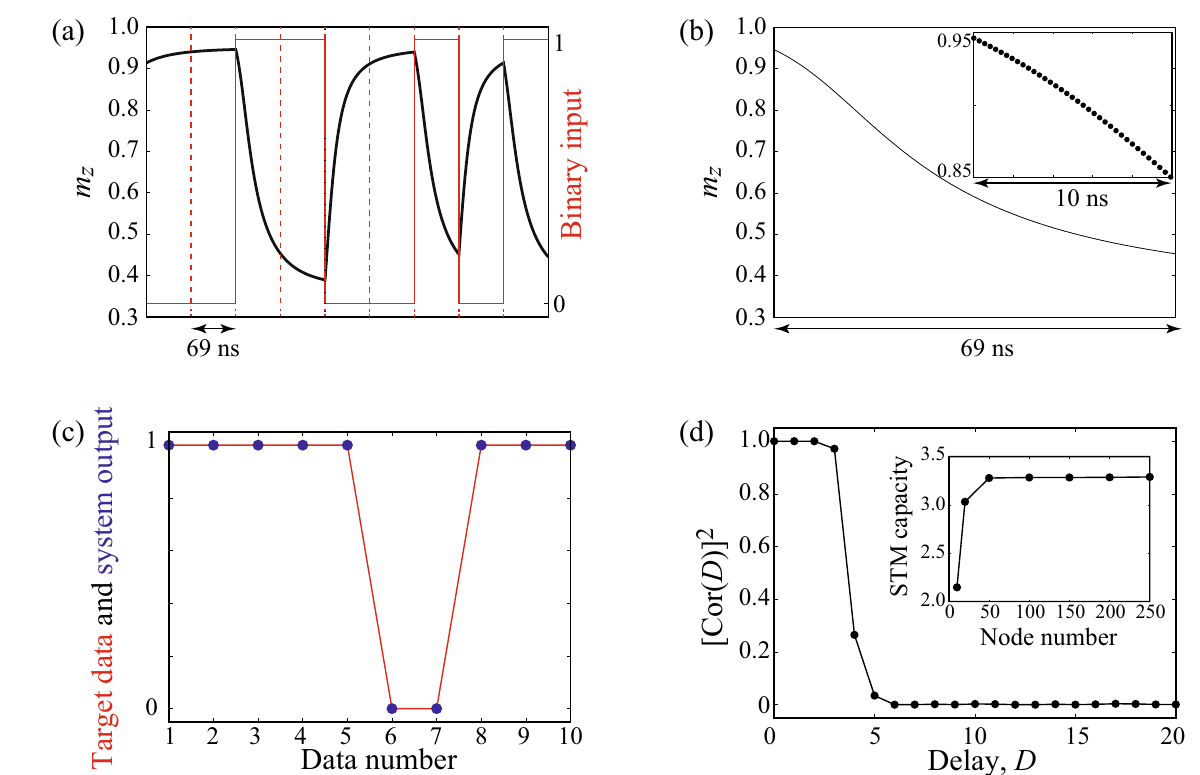
Figure 5. ( a ) An example of the time evolution of m z (black) in the presence of several binary pulses (red). The dotted lines distinguish the input pulse. The pulse width and the first order magnetic anisotropy field are 69 ns and − 430 Oe, respectively, where the STM capacity is maximized. ( b ) An example of m z in the presence of a random input. The dots in the inset shows the definition of the nodes u k , i from m z during a part of an input 250 . ( c ) Examples of the target data y ′ pulse. The node number is N node n , D (red line) and the system output = 2 on the delay D for STM task. The node 1 . ( d ) Dependence of Cor ( D ) D v ′ n , D (blue dots) of STM task with = [ ] 250 . The inset shows the dependence of the STM capacity on the node number is N node =